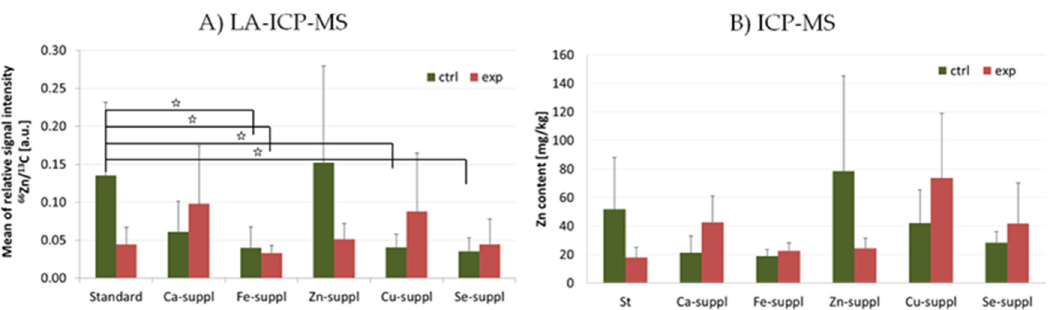
Figure 4. ( A ) Averaged relative signal intensities 66 Zn/ 13 C from “W” ROI (LA-ICP-MS analysis) compared with ( B ) Zn content in the same prostate gland samples quantified by ICP-MS with solution nebulization [68].